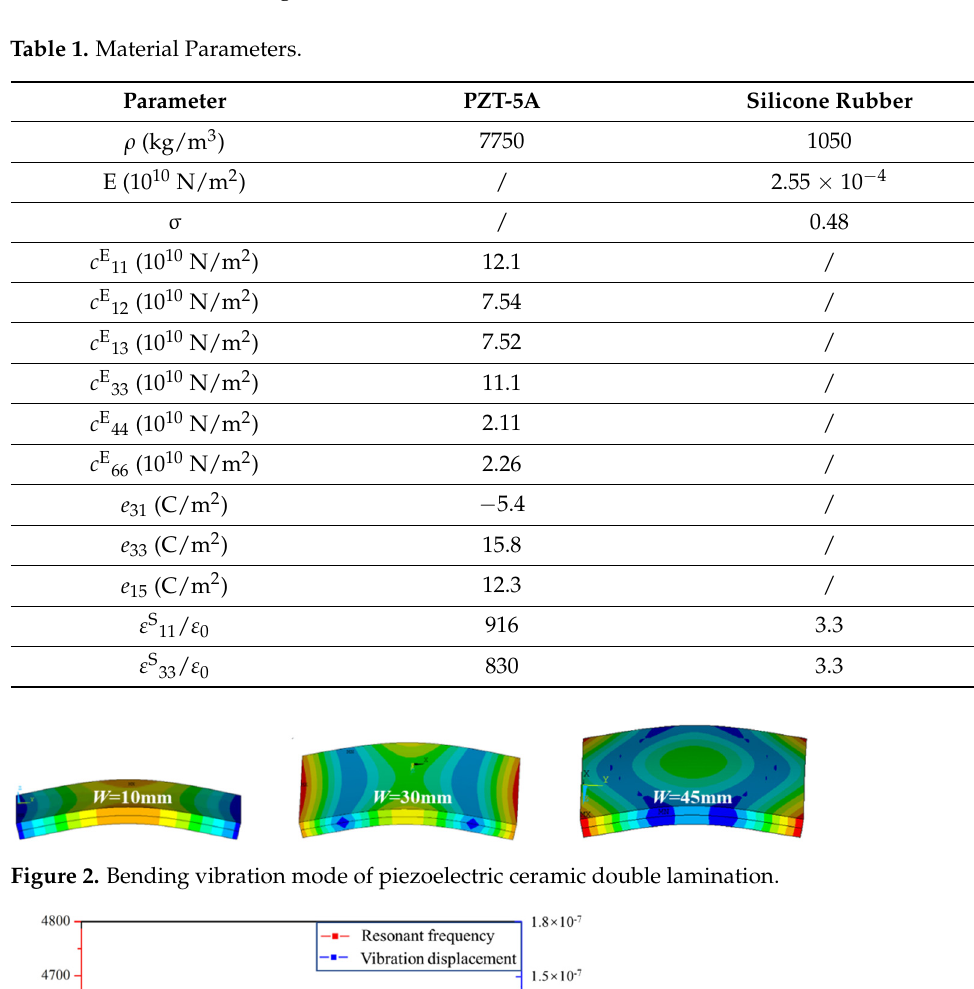
Table 1. Material Parameters.